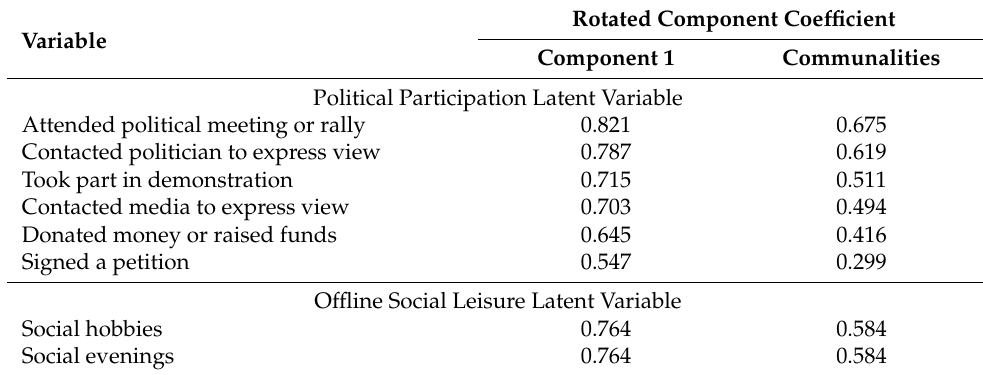
Table 2. Rooted Structure Matrix for PCA with Varimax Rotation of Both Latent